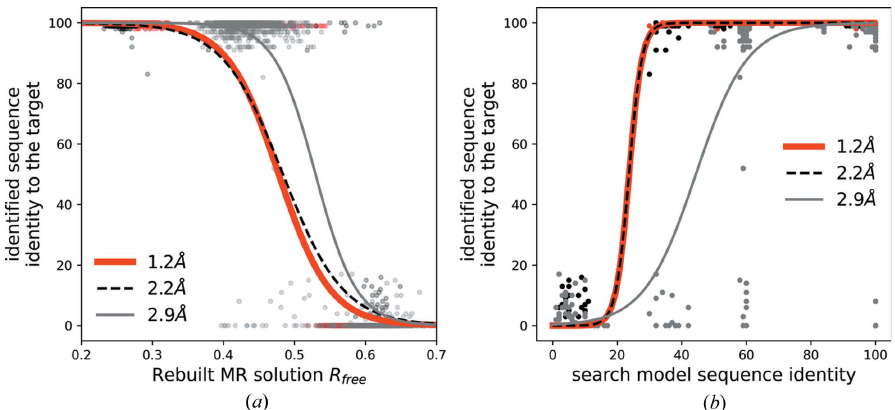
Figure 2 Sequence-identification benchmarks for crystal structure models solved with MR using Phaser . Sequence identity of an identified sequence to the target sequence as a function of ( a ) R free -factor value of a MR solution rebuilt using ARP/wARP without an input sequence and ( b ) sequence identity of a MR search model to the target structure. The continuous and dashed curves are logistic regression estimates of a probability that an identified sequence will have at least 80% sequence identity to the target